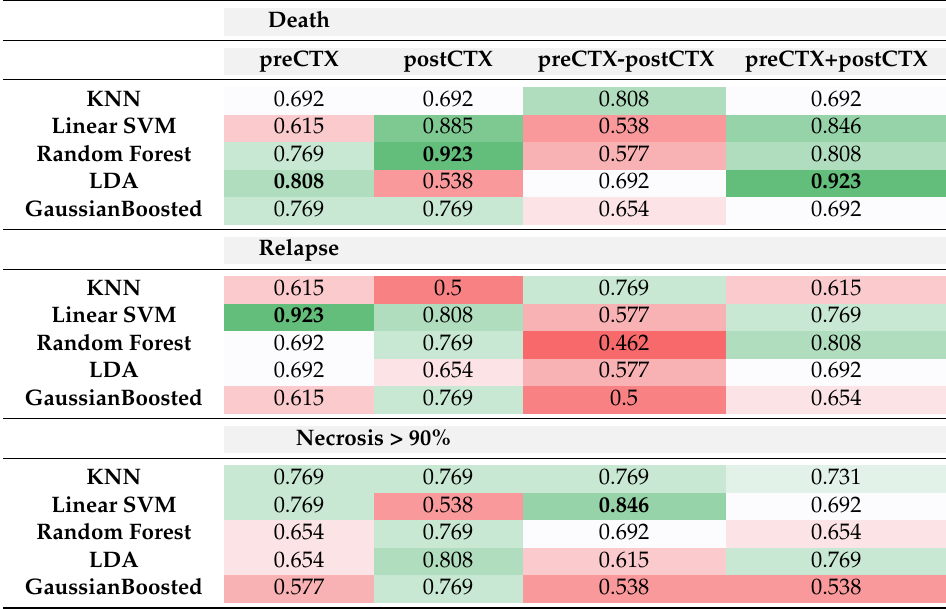
Table 2. Leave-one-out cross-validation accuracy for models calculated on reduced spectral feature